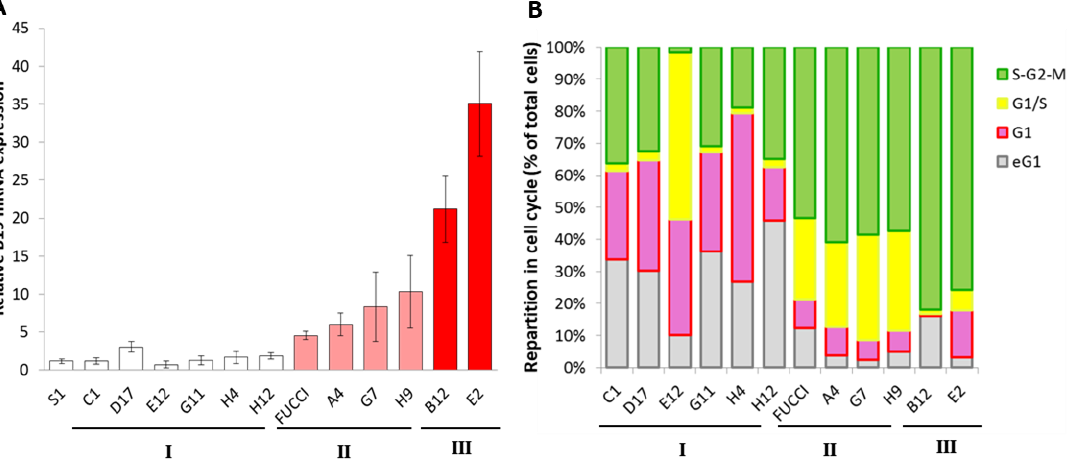
Figure 5. Improvement of B19V sensitivity and permissiveness according to cell cycle status. ( A ) UT7/Epo-S1 cells (S1), UT7/Epo-STI cells expressing the FUCCI system (FUCCI) and 11 UT7/FUCCI- derived isolated clones were inoculated with B19V. Relative levels of B19V mRNA were determined 72h post-infection, with UT7/Epo-S1 as the reference, and cell lines were classified on the basis of B19V sensitivity as group I for S1-equivalent clones, group II for FUCCI-equivalent clones, and group III for highly permissive clones. The results shown are the means + SD of 3 independent experiments for groups I and II, and n = 9 for group III clones. ( B ) The cell cycle status of exponentially growing FUCCI cell lines and isolated clones was assessed by flow cytometry. The results shown are the means + SEM of three independent measurements.